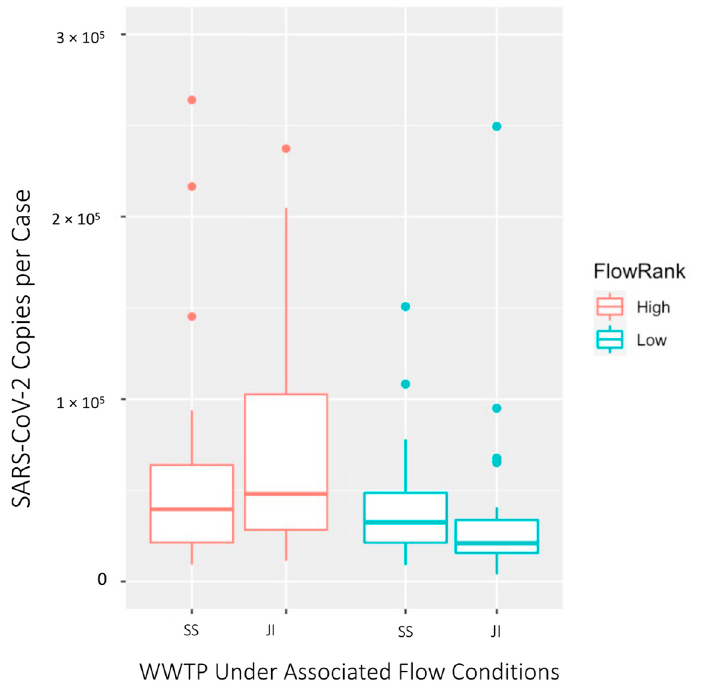
Figure 4. Case-adjusted loads (daily) among the highest and lowest third of average daily flow rates from 62 pairs of samples from JI and SS WWTPs.